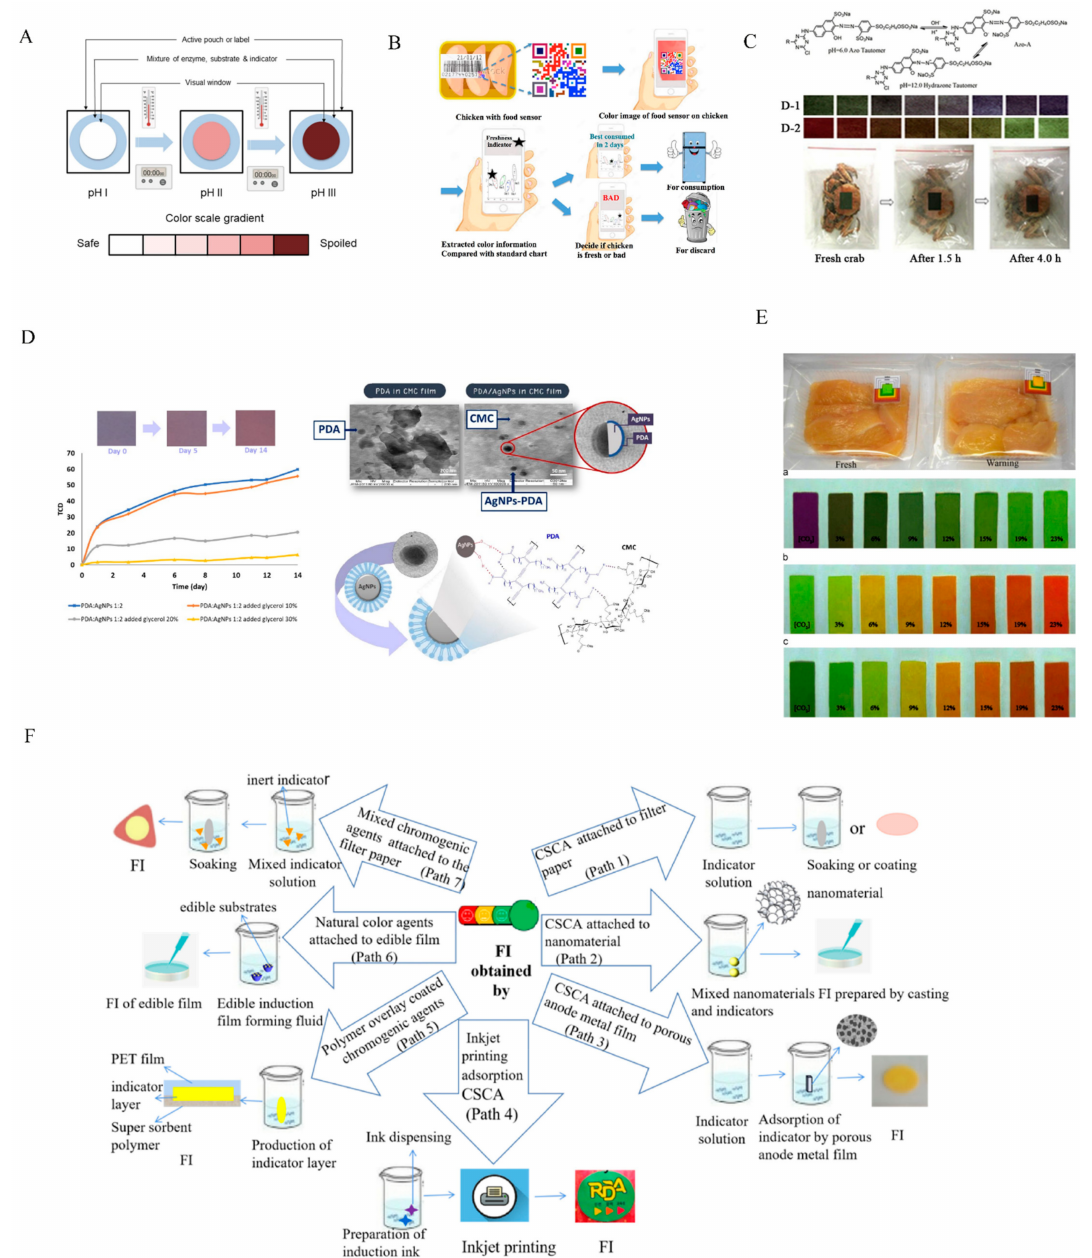
Figure 3. Several typical TTI and FI practical applications. ( A ) Working principle of enzyme time– temperature indicator in food packaging [11]. ( B ) Schematic of device application as food quality sensor [19]. ( C ) Intelligent color-changing paper with pH-sensitive chromophore packaging sen- sor [14]. ( D ) Using polydiacetylene/silver nanoparticles embedded in carboxymethyl cellulose [13]. ( E ) The food spoilage indicator that monitors the freshness of chicken breasts [16]. ( F ) Method of making FIs